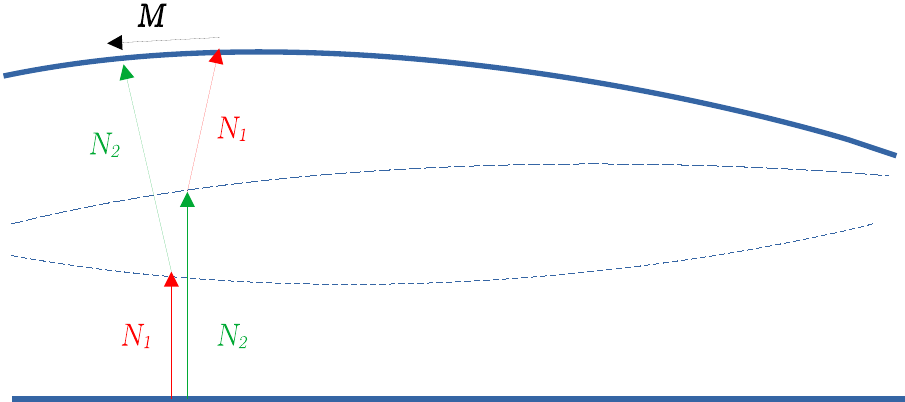
Figure 2. Two non-linear normal deformations, one with a lapse function N 1 and one with a lapse function N 2 , applied in two different orderings, show the commutator (15) given by a spatial displacement M